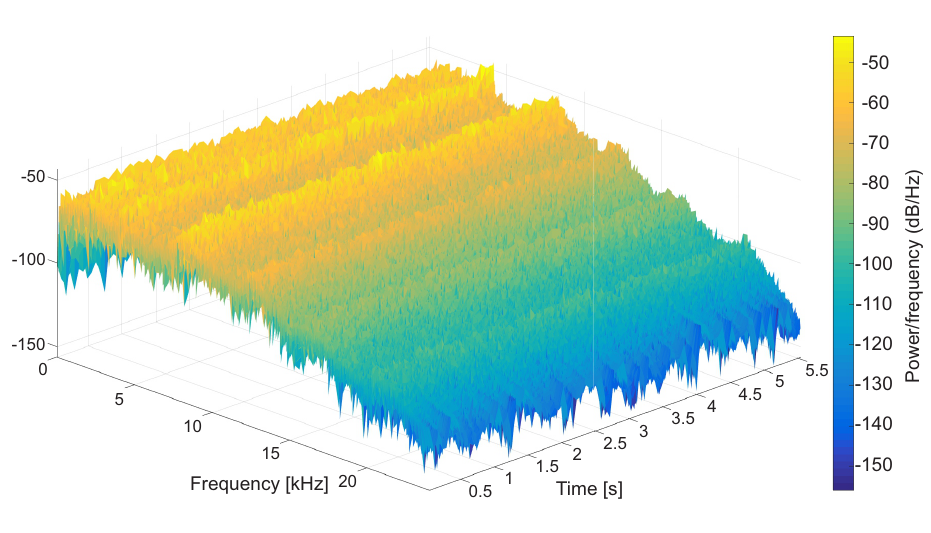
Figure 4. The spectrogram of an audio set for the case illustrated in Figure